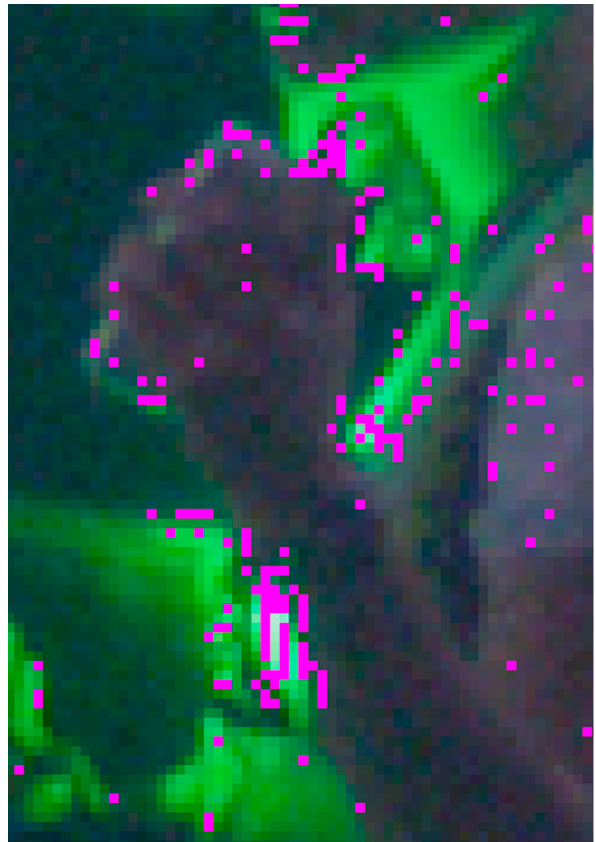
Figure A4. Top 1.5% pixels having the biggest quality difference between the proposed and the fast luma control schemes. The magenta pixels are attributed mostly to the tPSNR-Y difference between the “Fast” and the “Proposed” luma control schemes.